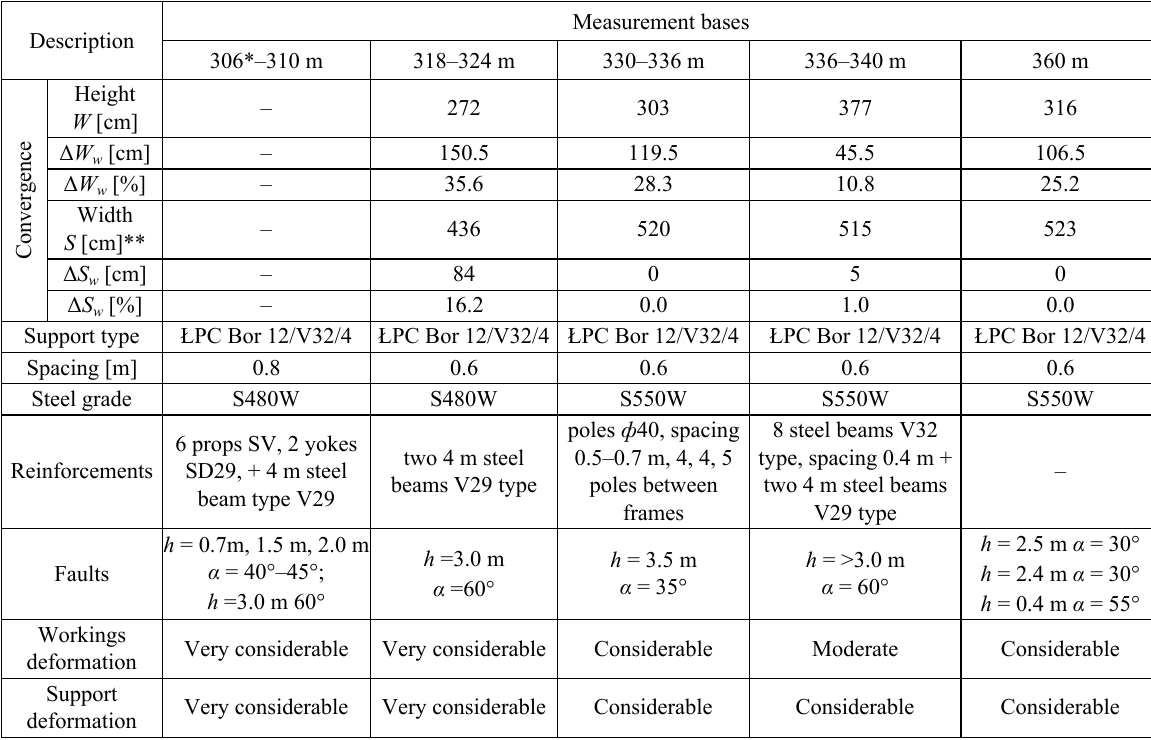
Fig. 8. The map of the analyzed section of drift W level 838 Table 5. Support details and results of measurements in drift W level